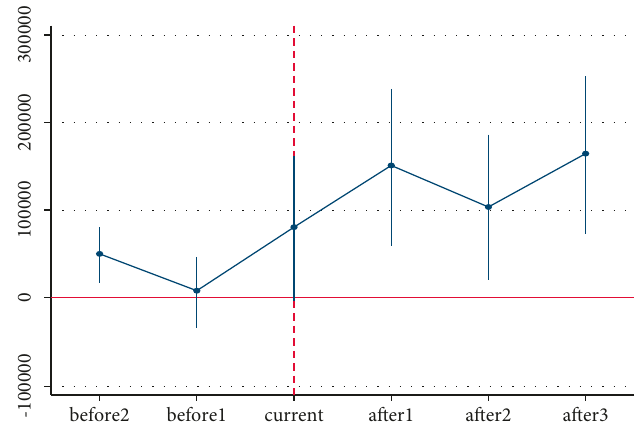
Figure 2: Parallel trends in domestic tourist